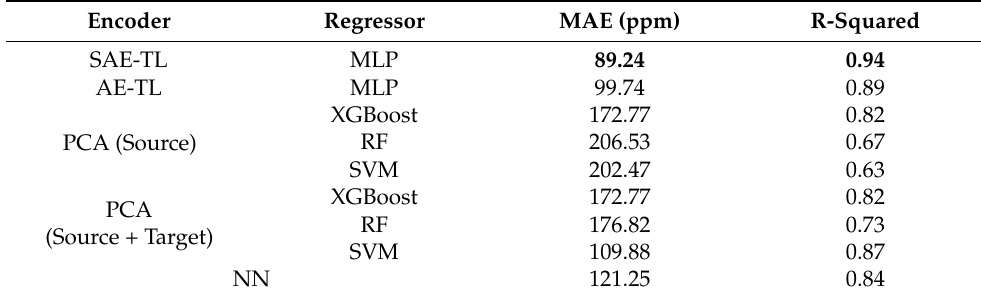
Table 3. Generalization performance of the proposed TL method on test sensor